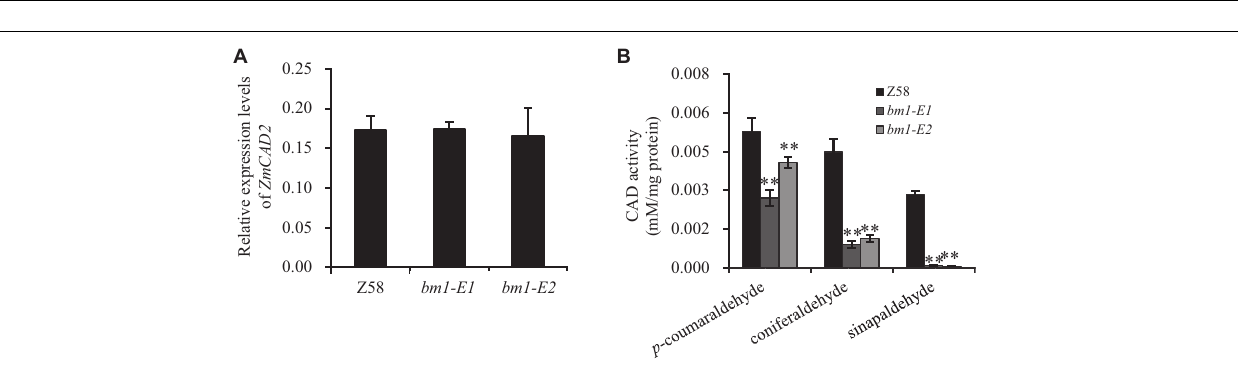
FIGURE 2 | Amino acid sequence alignment of predicted cinnamyl alcohol dehydrogenase proteins. The mutant amino acid was highlighted in red color. The protein sequences of ZmCAD2 was aligned with ZmCAD2-1, ZmCAD2-2, and AtCAD4 proteins using ClustalW. AtCAD4: Arabidopsis thaliana P48523.1; ZmCAD2: Zea maize GRMZM5G844562. (cid:78) indicates the mutant amino acids; the line indicates the nucleotide biding domain.